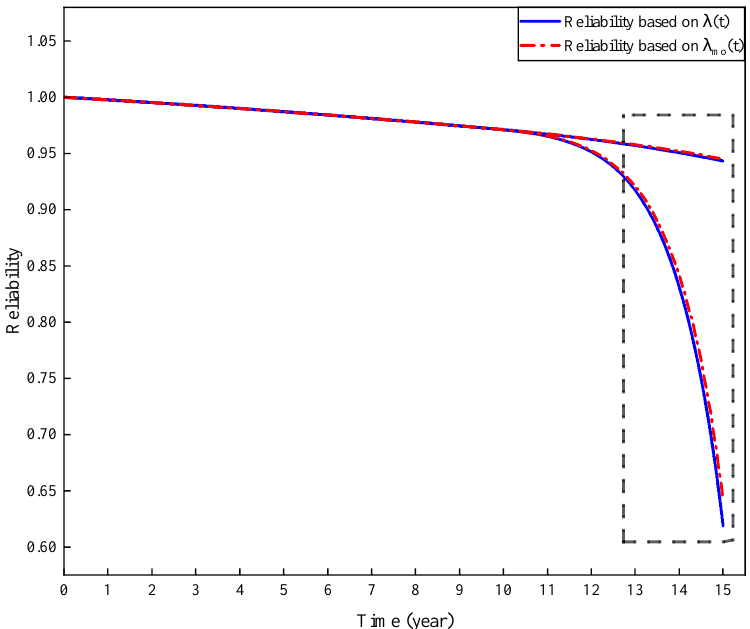
Figure 10. Reliability curves comparison diagram based on time-varying failure rate models before and after